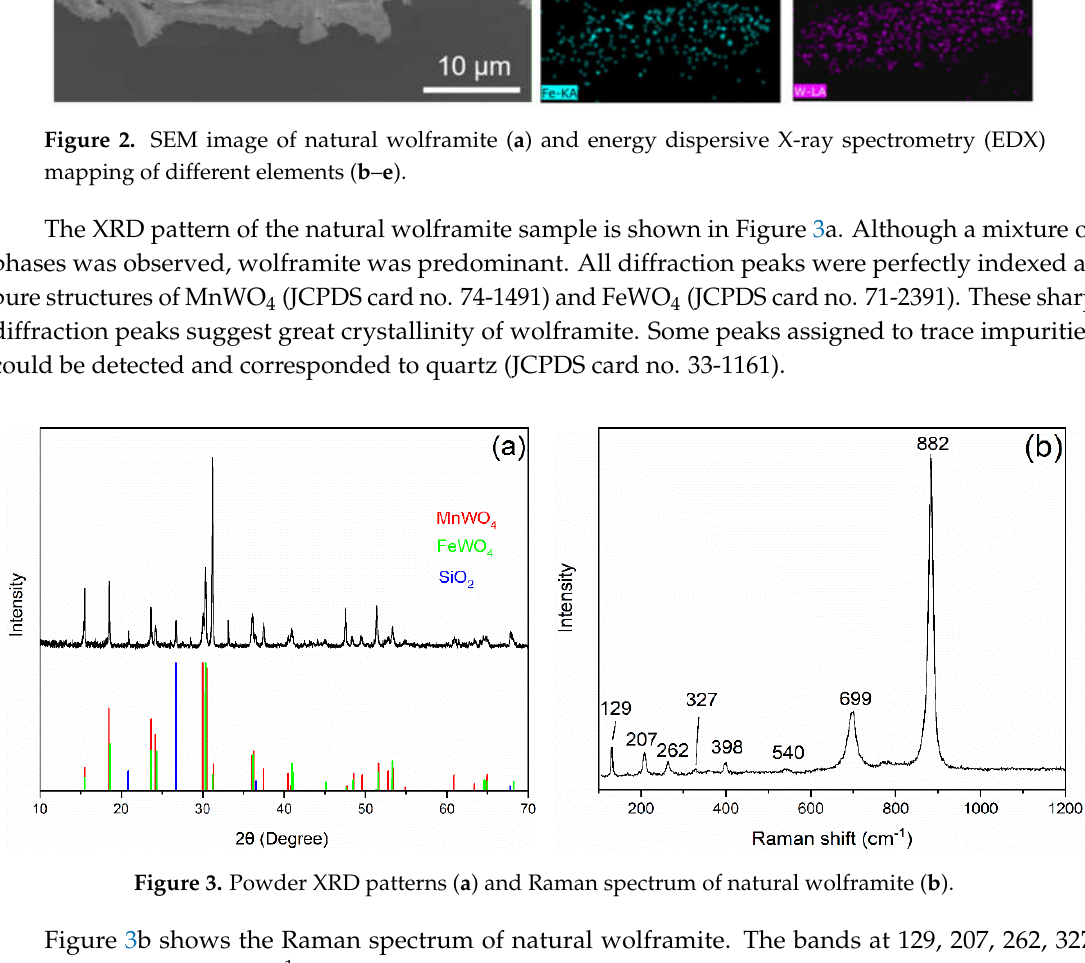
Figure 2. SEM image of natural wolframite ( a ) and energy dispersive X-ray spectrometry (EDX) mapping of different elements ( b – e ).